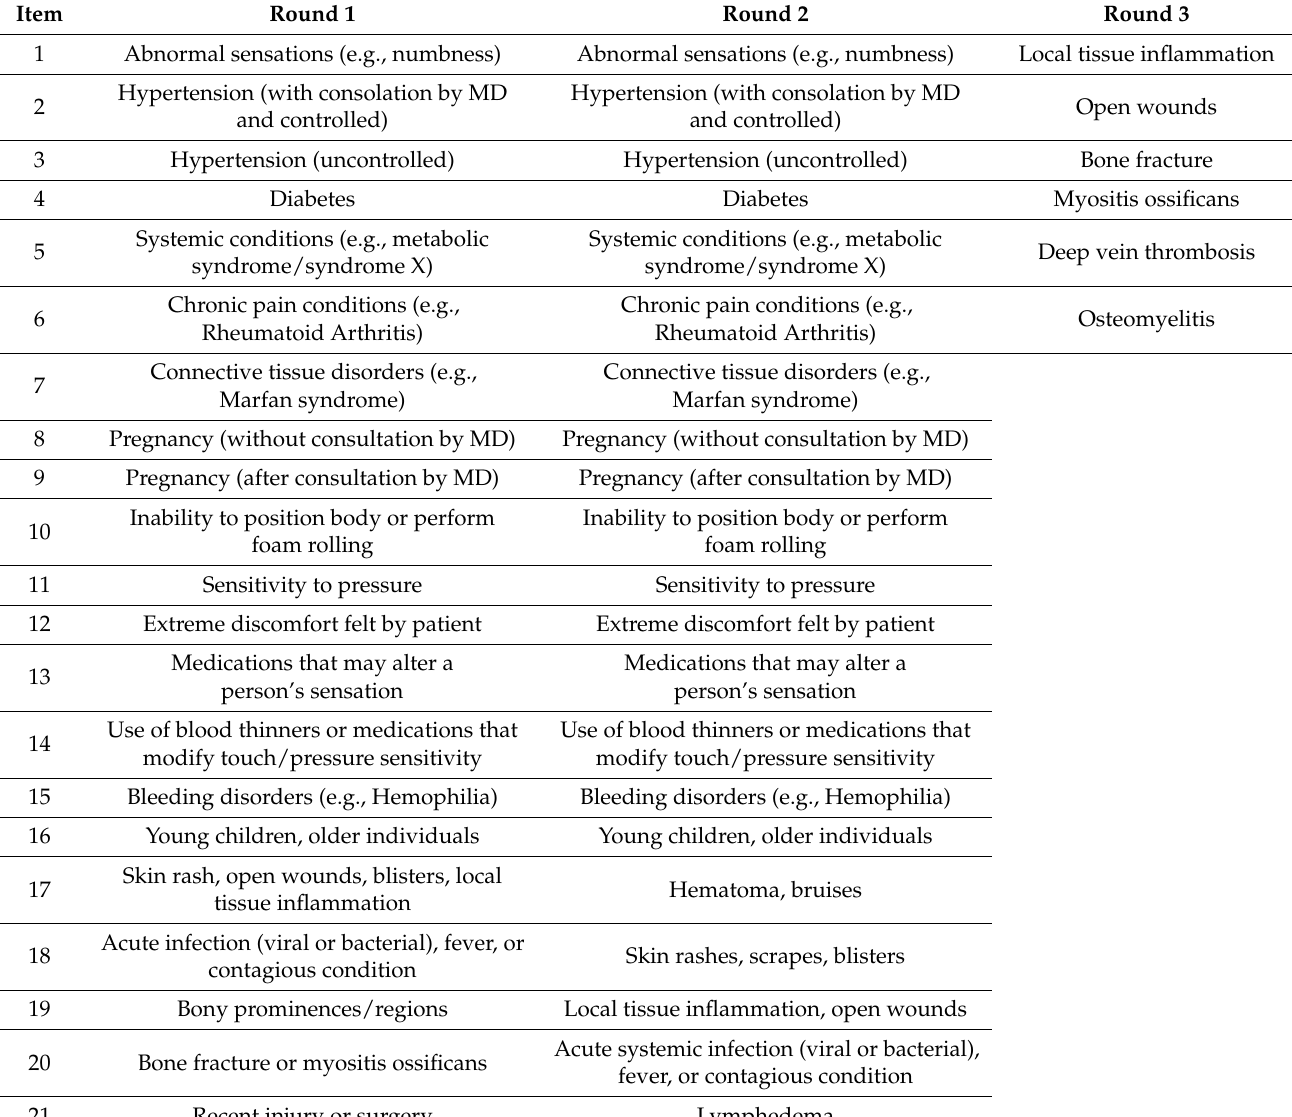
Table 2. Conditions to be rated throughout Delphi process rounds